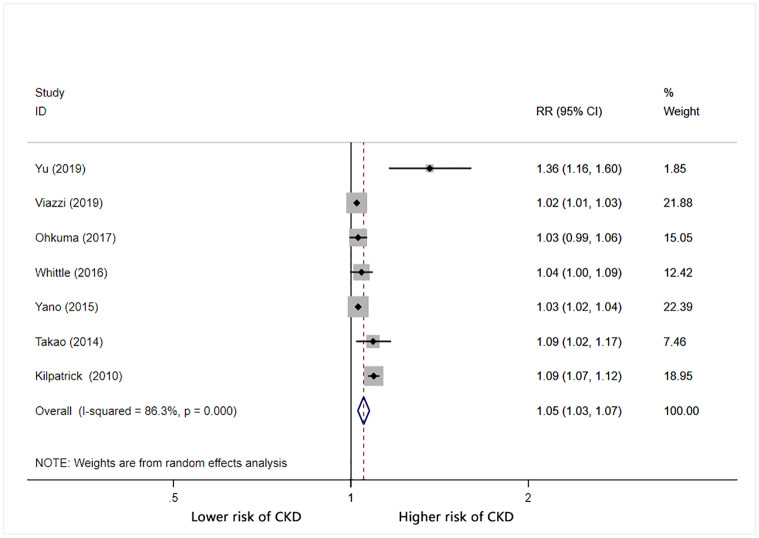
Forest plot of relationship between 1 mmHg increment in SD-SBP and risk of CKD.Boxes represent the Relative risk (RR) and lines represent the 95% Confidence Intervals (CIs) for individual studies. The area of each square is proportional to study weight. The diamonds and their width represent the pooled RRs and the 95% CIs, respectively.